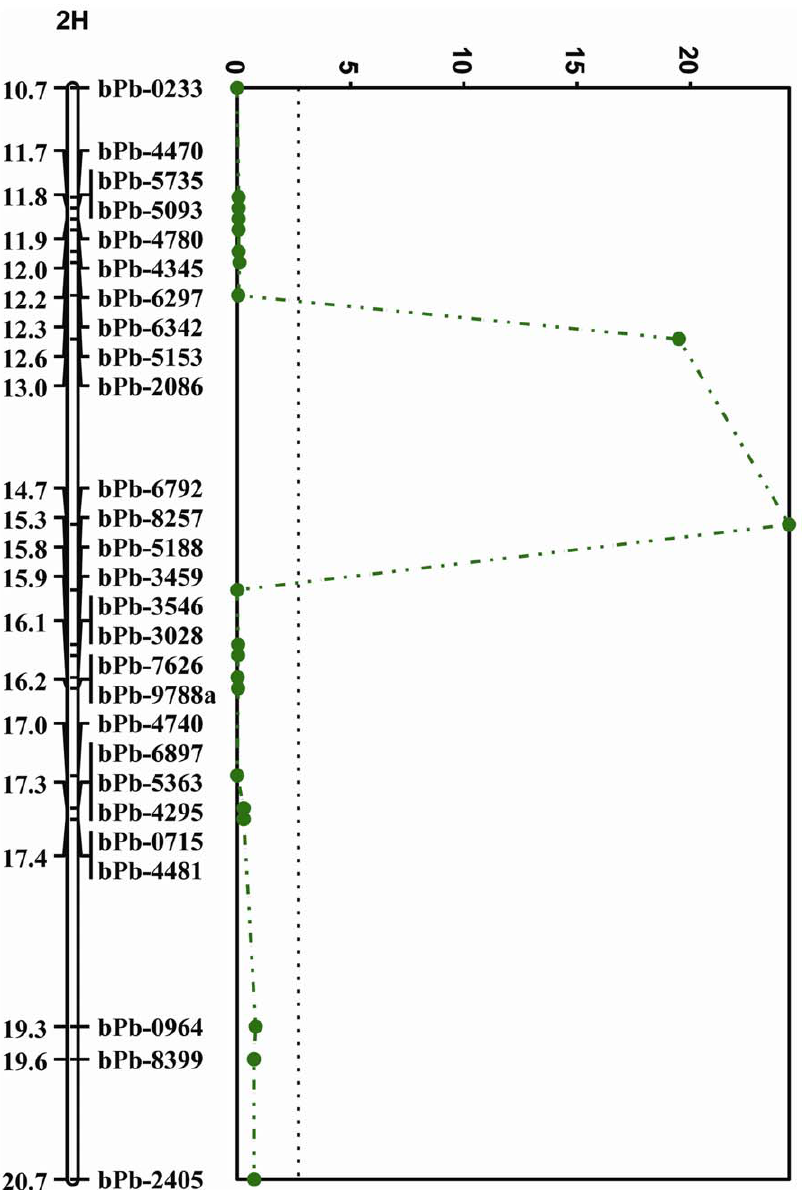
Figure 5. The QTL associated with salinity tolerance (LOD values). Only part of 2H was presented. The dotted line at LOD 3.1 is a line of significance.